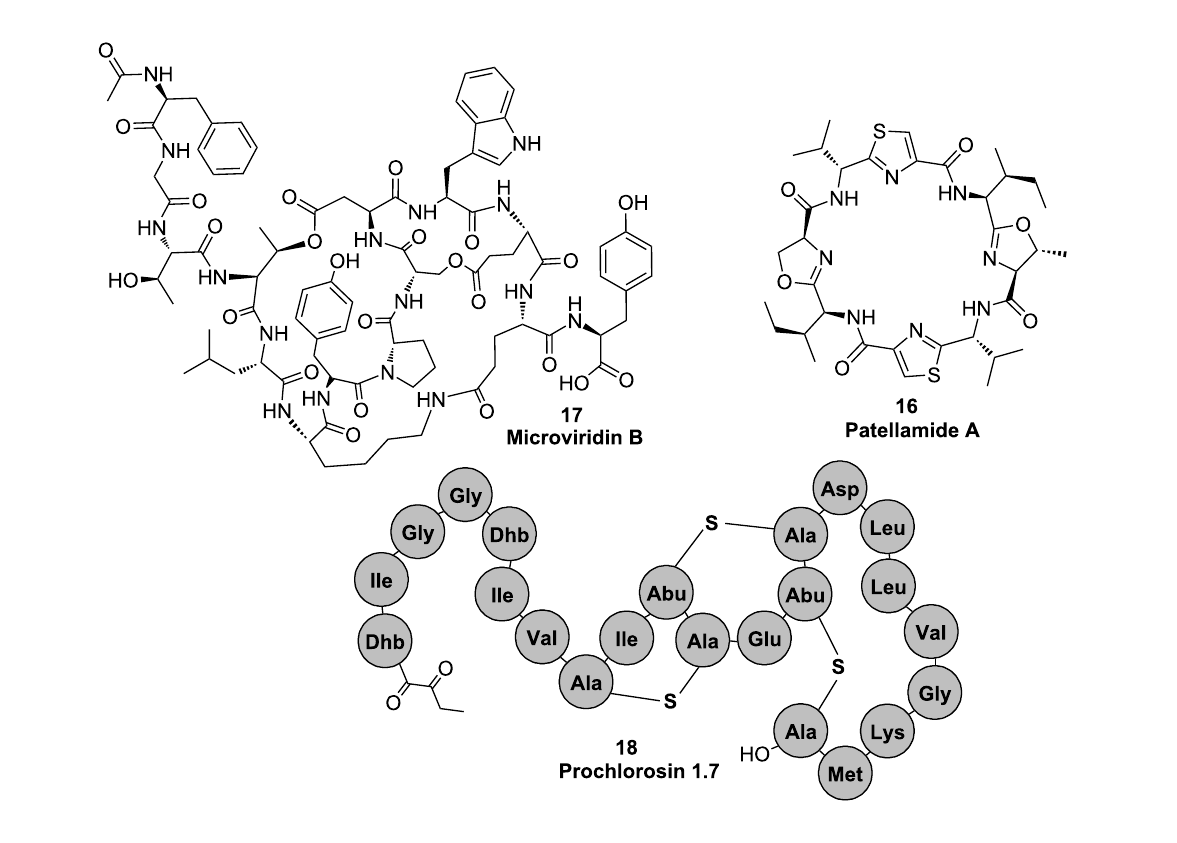
Figure 9: Structures of cyanobacterial peptides that are synthesized ribosomally and post-translationally modified.